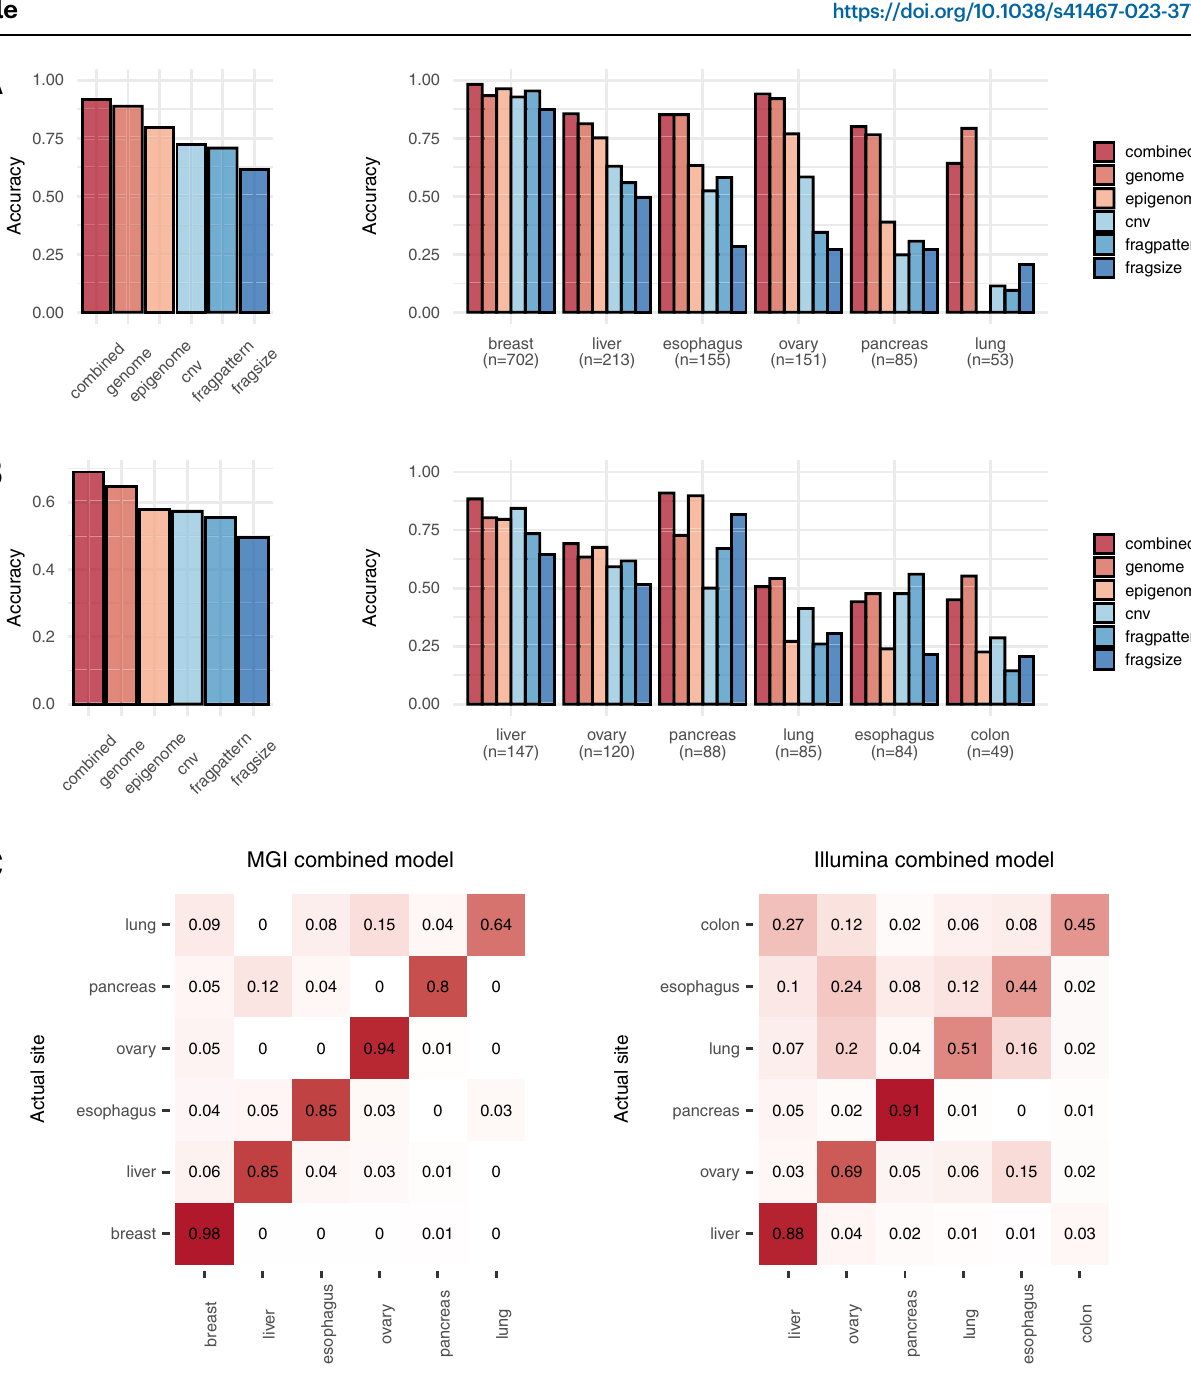
Thenumbersinthecellsofthematrixrepresenttheproportionofsamplesofeach cancertypelocalizedto respective tumor sites. A – C Our genome, epigenome,and combined models were compared with predictions based on fragmentation patterns 9 (fragpattern), fragment size pro fi les 8 (fragsize), and copy number variations 3 (cnv). Source data are provided as a Source Data fi